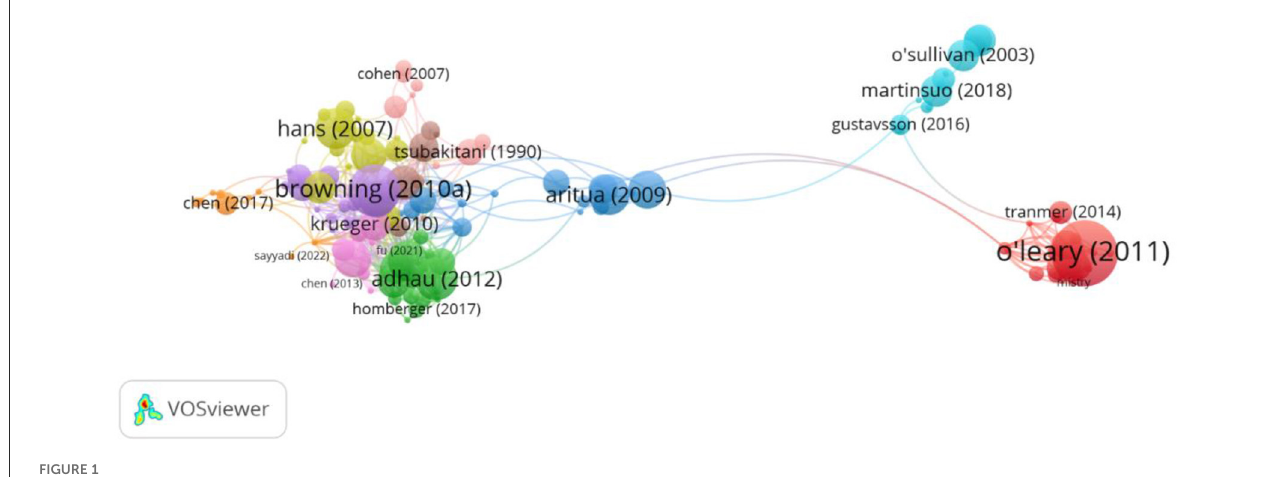
FIGURE1 Citation analysis based on 134 documents.